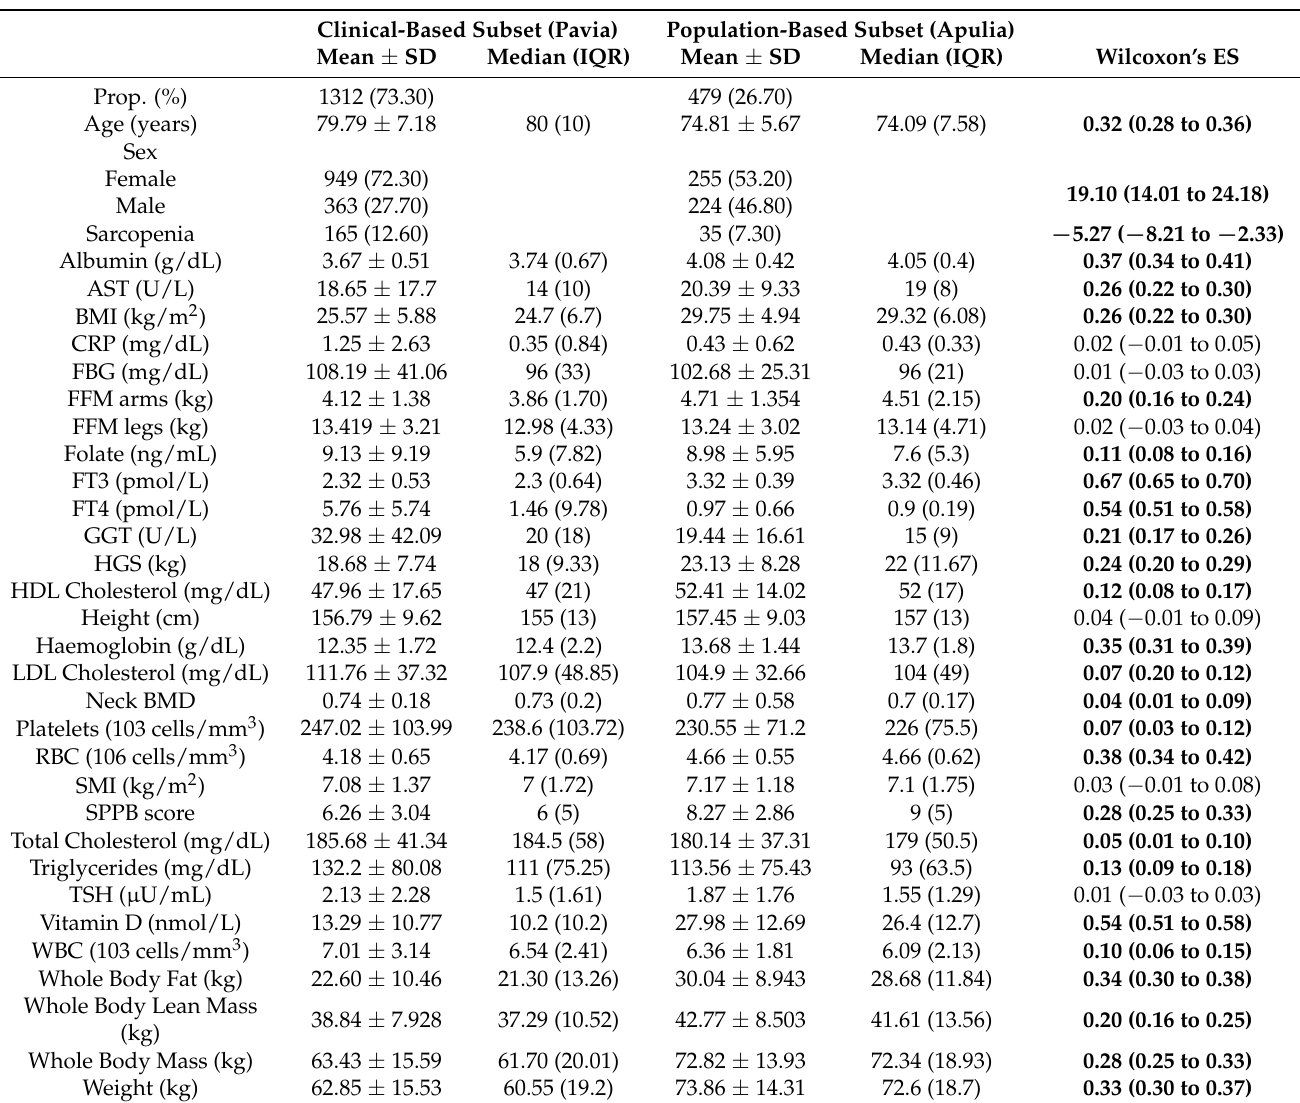
Table 1. Description of the whole sample according to population setting, i.e., northern (clinical setting) versus southern (population-based setting)